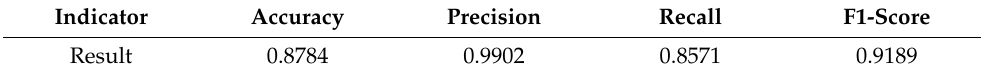
Table 4. Performance evaluation of the CAE network from four indicators in the case of the test dataset.